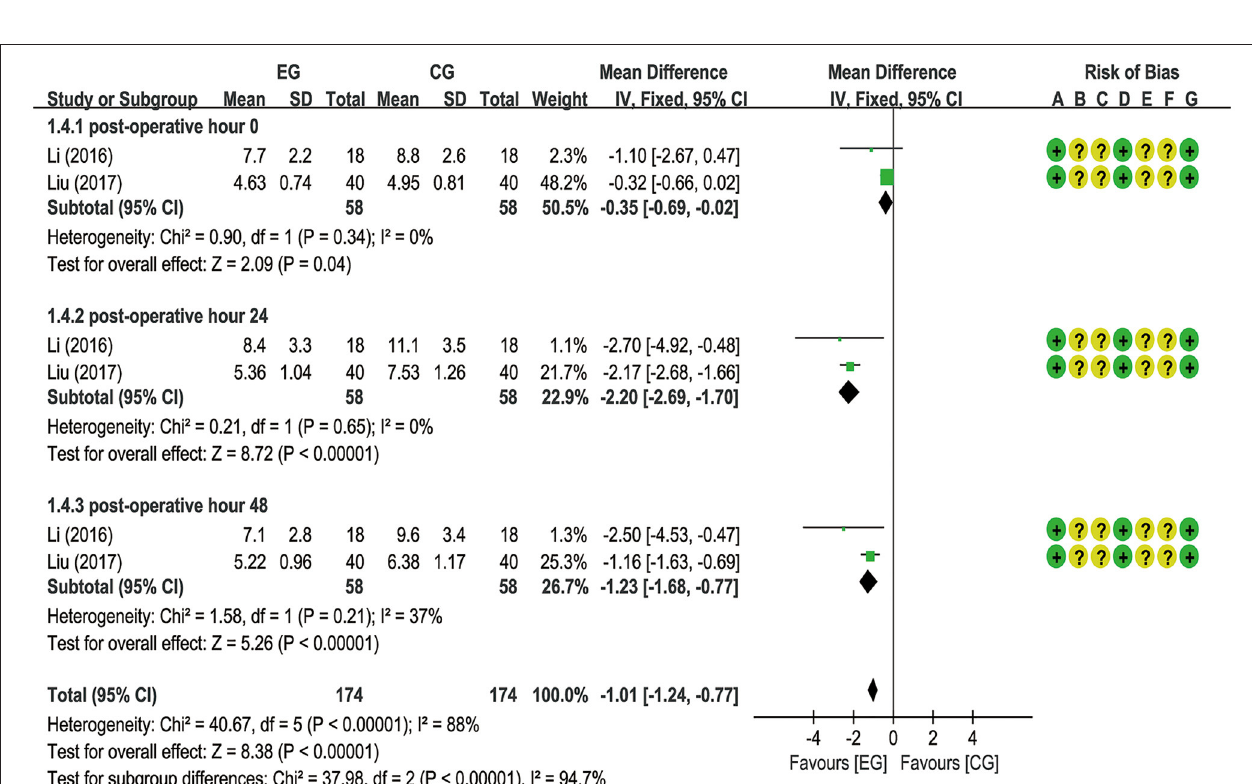
FIGURE 5 | Meta-analysis and forest plot and for neuron-specific enolase (NSE) at different periods.